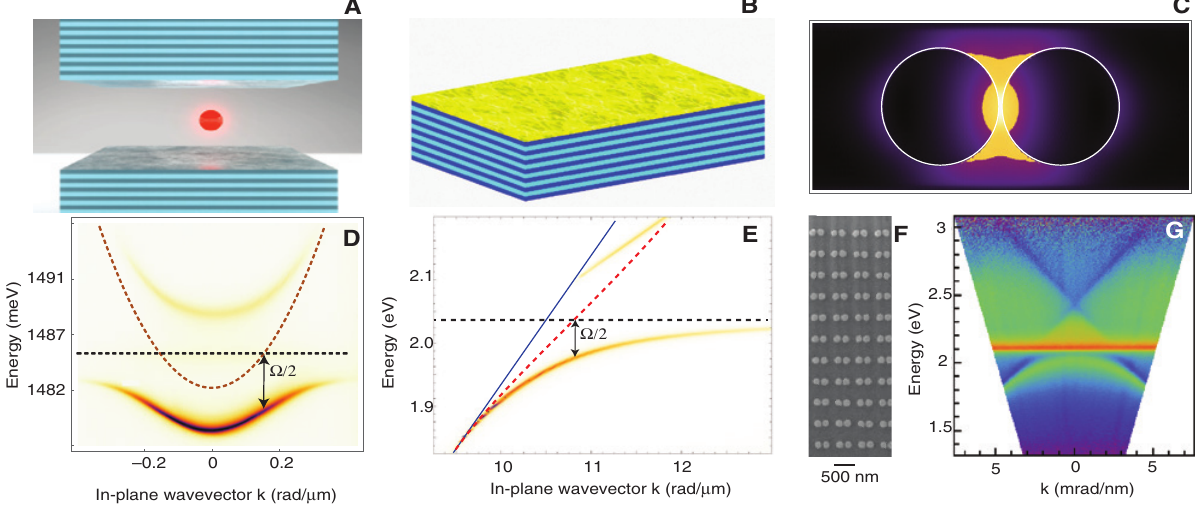
Figure 2: Photonic structures showing strong coupling with a matter resonance in the visible range. (A) Cavity made of two DBR mirrors with the exciton dipole represented by the red sphere. (B) Bloch surface wave (BSW) sustained on the top of a single DBR, with the thin active layer deposited at the maximum enhancement of the electromagnetic field. (C) Spatial distribution of the electromagnetic field (numerically simulated by FDTD) at resonance with a gap-plasmon, with the maximum enhancement localised within the two metallic nanoparticles. (D) Dispersion of the microcavity polariton associated with the structure in (A): the parabolic dispersion of a photon in a cavity (red dashed line) and the flat dispersion of the exciton (black dashed line) in this angular range show a clear anti-crossing with vacuum Rabi energy ℏ Ω = 4 meV and exciton-cavity detuning δ = –3 meV [86]. (E) Dispersion of organic BSW polaritons. The light line is defined by the interface between the heterostructure and air (blue line). The Rabi energy anti-crossing between the the BSW (red dashed line) and the exciton (black dashed line) is Ω = ℏ 50 meV [87]. (F) SEM image of an array of plasmonic nanoparticle dimers as in (C), where hybridisation can occur between the localised plasmons, the surface modes associated with the lattice, and the organic molecular exciton of the deposited material. (G) Dispersion of the structure in (F), with an organic molecular layer deposited on top of the array of coupled nanoparticles. The anti-crossing is small compared to the line width but still visible [88]. Additional details on the parameter structures can be found in Refs